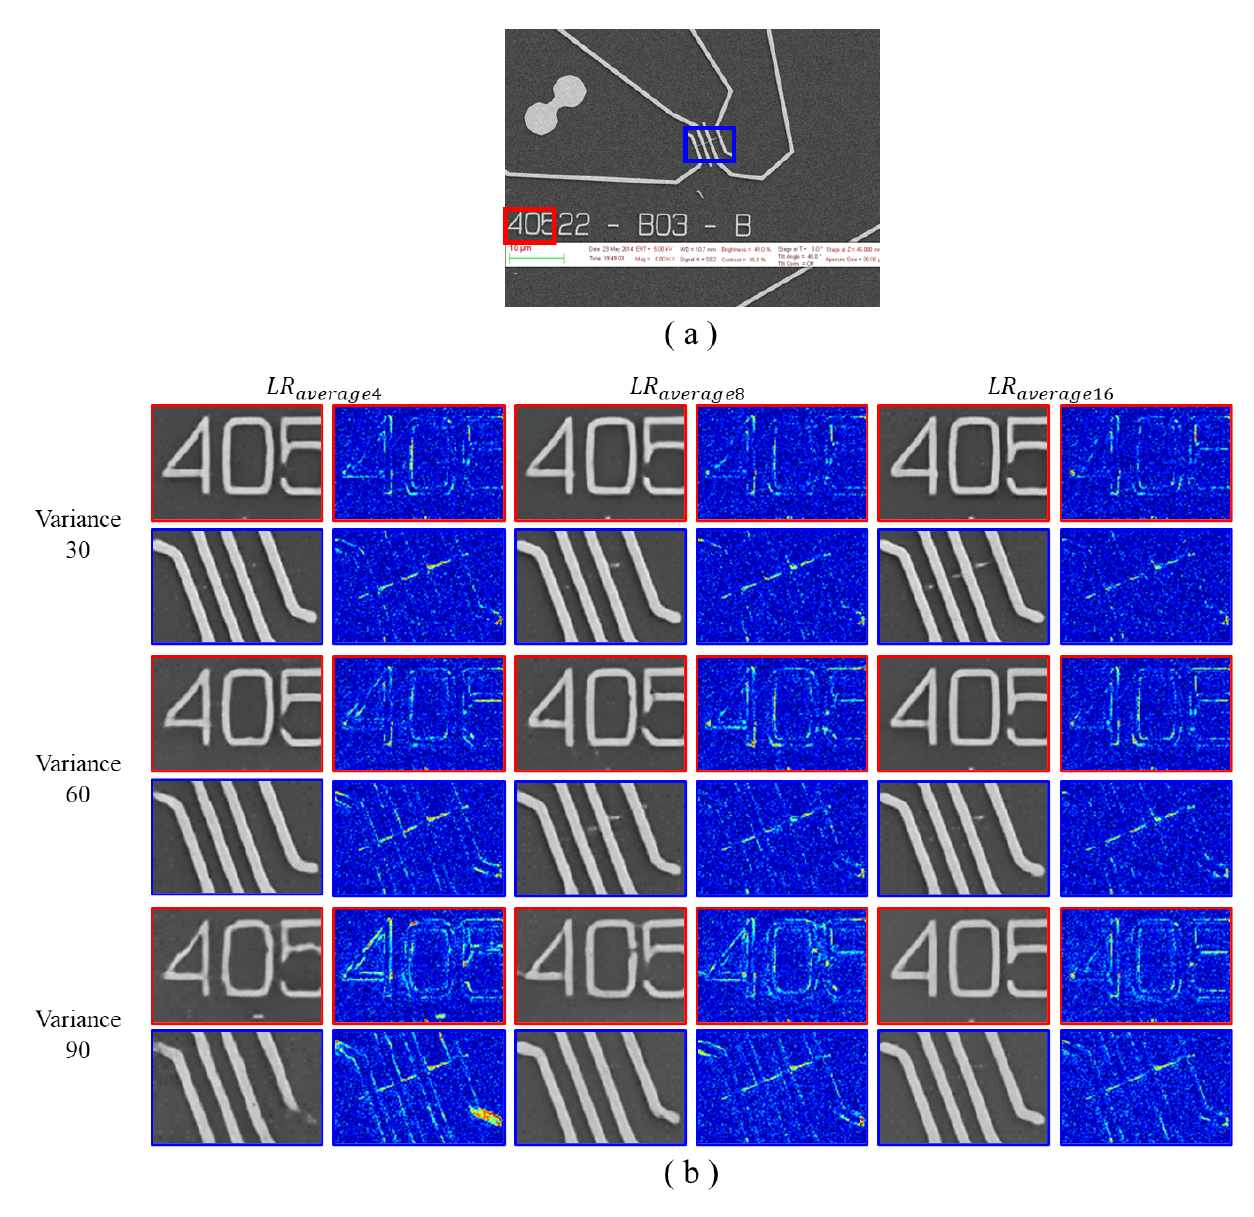
Figure A2. Qualitative comparison of our proposed scheme for different noise levels and different numbers of averaged images during denoising: ( a ) full-resolution image is the HR target image, which is given as a reference for the positions of the magnified boxes; ( b ) magnified images and error map illustrated in the heat map for reference ( a ). Images are evaluated for different noise levels (variances of 30, 60, and 90) and different numbers of averaged images for denoising (4, 8, and 16 images used). The red and blue boxes show the magnified SR results and the error map trained for each setting for LR average images at each noise level, respectively. The error map is illustrated as a heat map, with the error between the SR and target HR images amplified five times for visual comparison. The baseline network chosen is